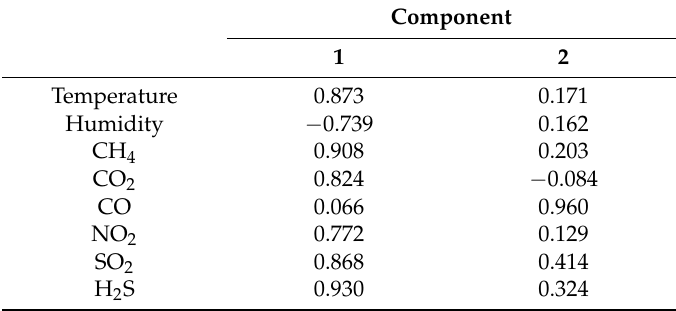
Table 7. Rotated component matrix and possible source identification.